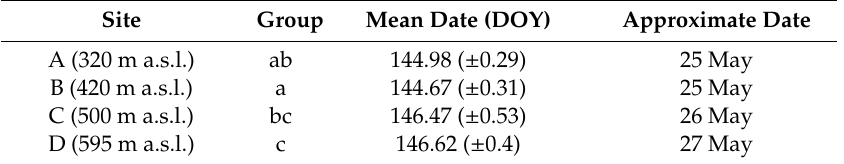
Table 4. Results of the post hoc test used to assess differences in the bud break process in the study sites. The parameter being tested is the mean date of completion of the bud break process (in day of the year values). “Group” letters identify statistically different groups, where “a” is the group with the lower value. Dates are expressed as “day of the year” (DOY) progressive values, the corresponding dd/mm dates are also shown. Values in brackets represent the standard error (S.E.).